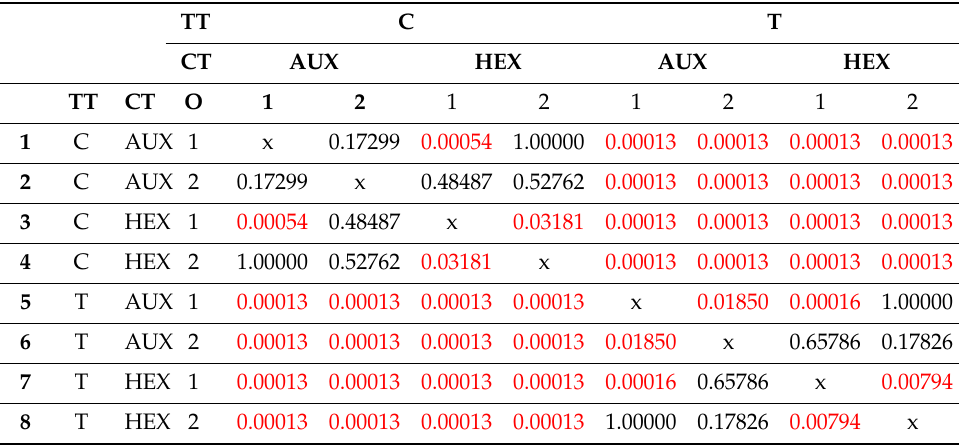
Table 5. Tukey’s HSD test for K variable (Nm / rad).